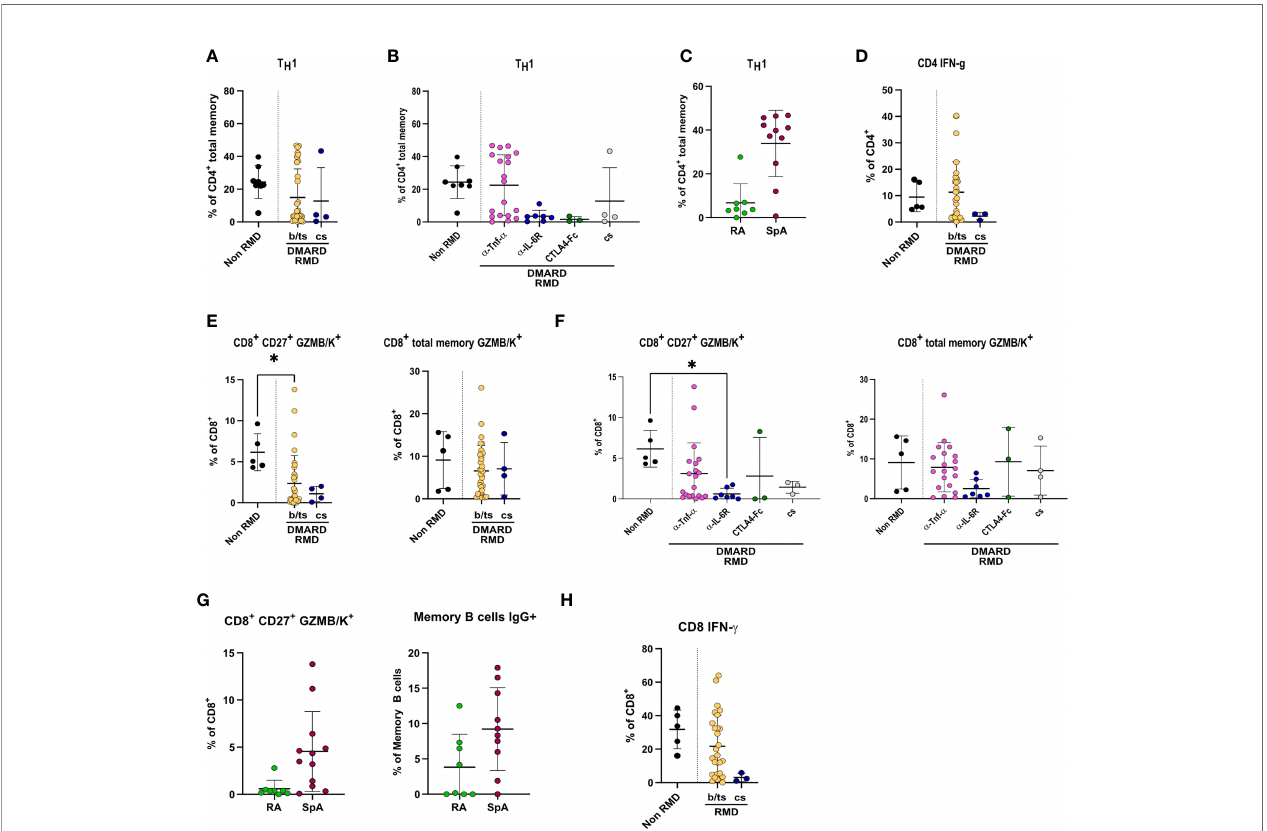
FIGURE 5 | Speci fi c DMARD treatments drive alterations in T H 1 and effector CD8 + T cells in serologically positive RMD patients. Relative frequencies of T H 1 cells in (A) non-RMD patients ( N = 8) and RMD patients treated with b/ts- ( N = 31) or cs-DMARDs ( N = 4). (B) RMD patients undergoing different b-DMARD ( a -TNF- a , N = 19; a -IL-6R, N = 7; CTLA4-Ig, N = 3) or cs-DMARD treatments ( N = 4), and non-RMD patients ( N = 8). (C) a -TNF- a -treated patients sorted according to disease (RA, N = 8; SpA, N = 11). (D) Relative frequency of CD4 + IFN- g + in non-RMD patients ( N = 5) and RMD patients treated with b/ts- ( N = 28) or cs-DMARDs ( N = 3). Immunophenotypic analysis of CD8 + T lymphocytes by fl ow cytometry. Relative abundance of CD8 + CD27 + GZMB/K + and CD8 + total memory GZMB/K + subpopulations in PBMC of non-RMD patients ( N = 5) and RMD patients sorted (E) by b/ts- ( N = 32) and cs-DMARD treatment ( N = 4) or (F) by the individual DMARD treatment (Non-RMD, N = 5; a -TNF- a , N = 20; a -IL-6R, N = 7; CTLA4-Ig, N = 3; cs-DMARD, N = 3). (G) Relative abundance of CD8 + CD27 + GZMB/K + and CD8 + total memory GZMB/K + subpopulations in RA ( N = 8) and SpA ( N = 10) treated with a -TNF- a . (H) Relative frequency of CD8 + IFN- g + in non-RMD patients ( N = 5) and RMD patients treated with b/ts- ( N = 28) or cs-DMARDs ( N = 3). Graphs show individual values, means, and SD. Statistical signi fi cance was